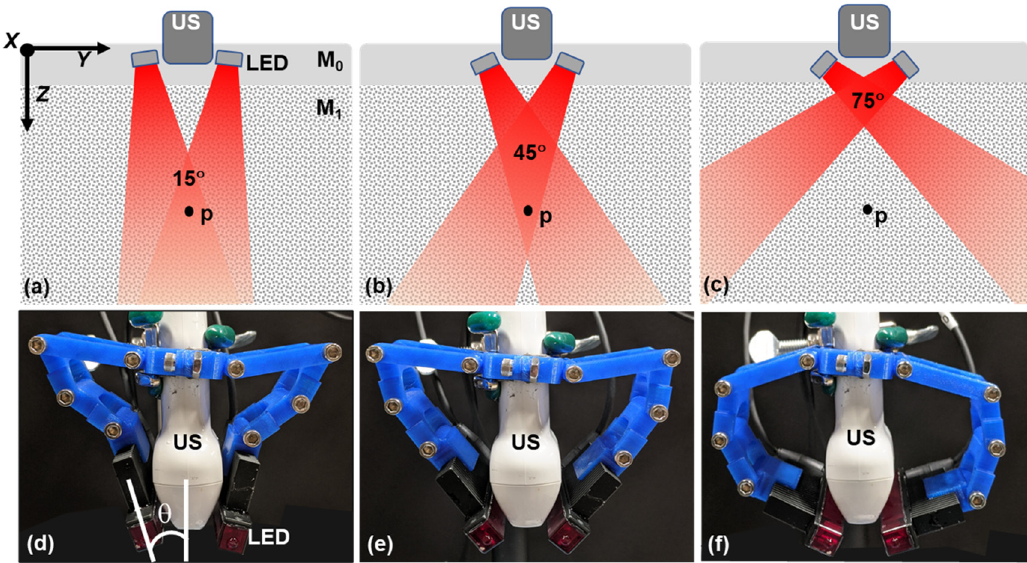
Figure 1. ( a – c ) Schematics of light emitting diode (LED) illumination cross-sectional view of photoacoustic (PA) setup at representative angles: 15 ◦ , 45 ◦ , and 75 ◦ , respectively, orthogonal to the imaging plane XZ , that contains a hypothetical absorber, p. M 0 is the medium that facilitates acoustic coupling between the transducer and the phantom material M 1 ; ( d – f ) Photographs of LED source pivoted at representative angles, θ = 15 ◦ , 45 ◦ , and 75 ◦ , respectively, using 3D printed modular hinge system.